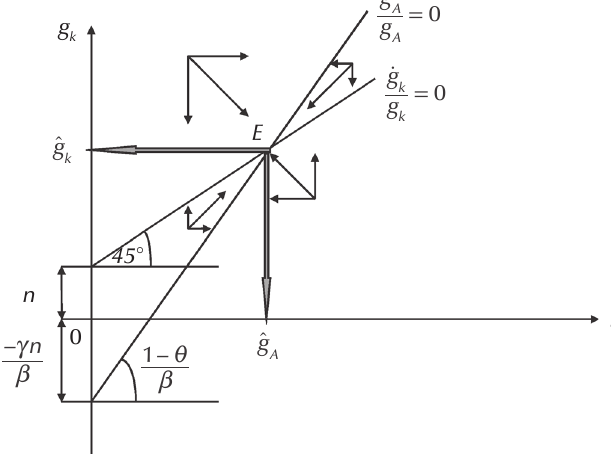
The dynamics of growth rates of capital and knowledge in